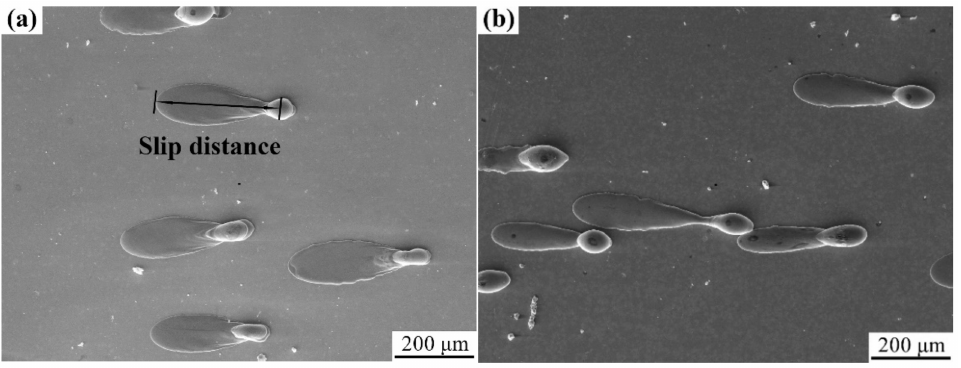
Figure 7. Slipping distance of 316L particles at impact angles of ( a ) 30 ◦ and ( b ) 15 ◦ deposited by flame spraying with acetylene flow rate of 150 L/h and spray distance of 40